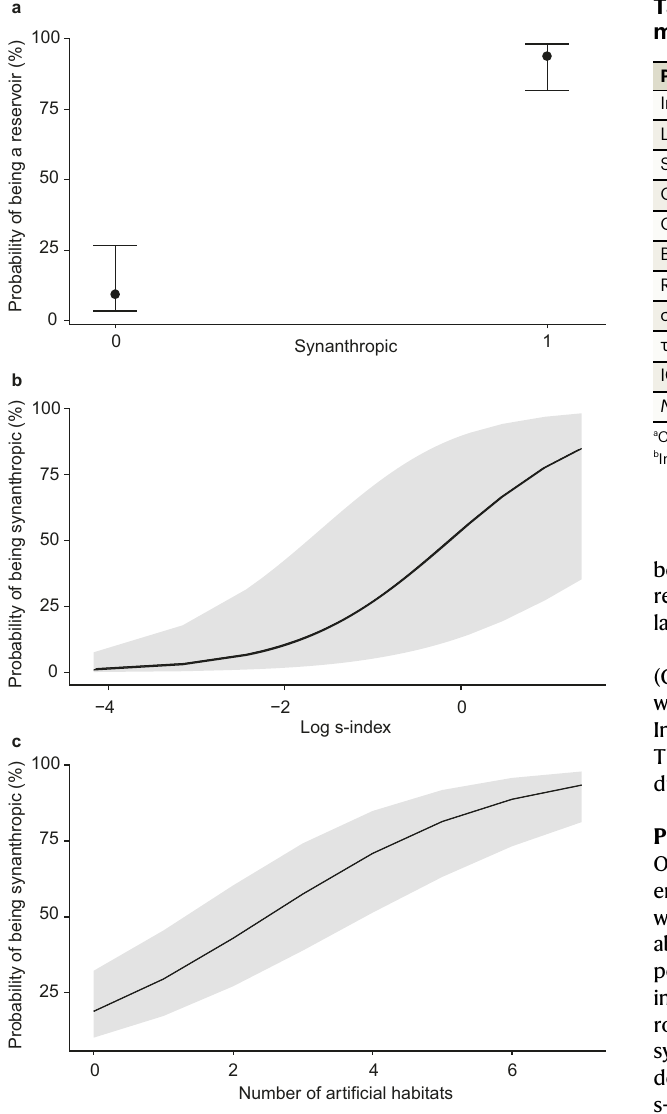
Table 1 | Summary of best- fi t generalized linear mixed